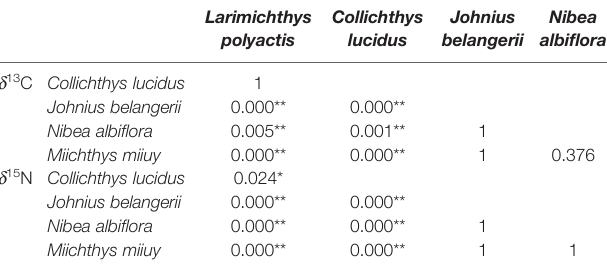
TABLE 2 | Comparison of d 13 C and d 15 N values of fi ve sciaenid fi sh species collected from the Zhoushan Archipelago between 2019 and 2021 based on the Kruskal-Wallis H test.